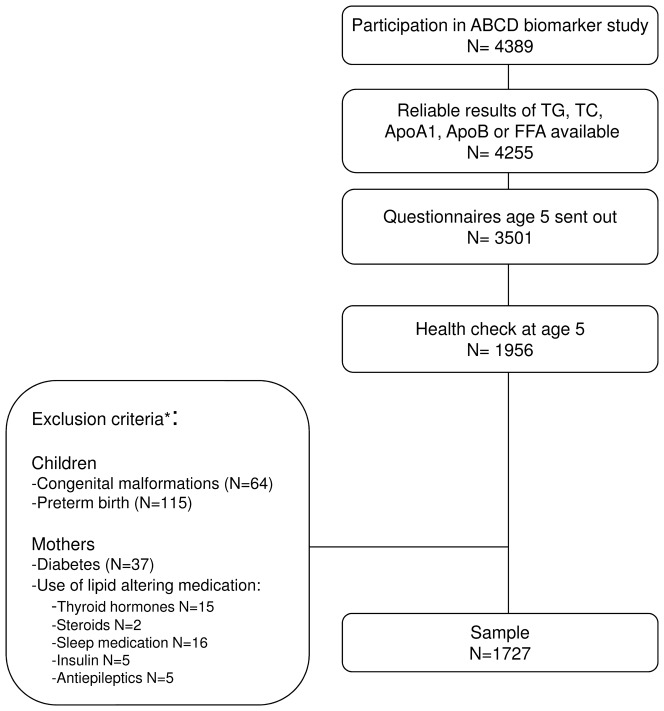
Flow chart of the study population.*Numbers sum to more than 229 as more than one exclusion criterion per mother was sometimes present.